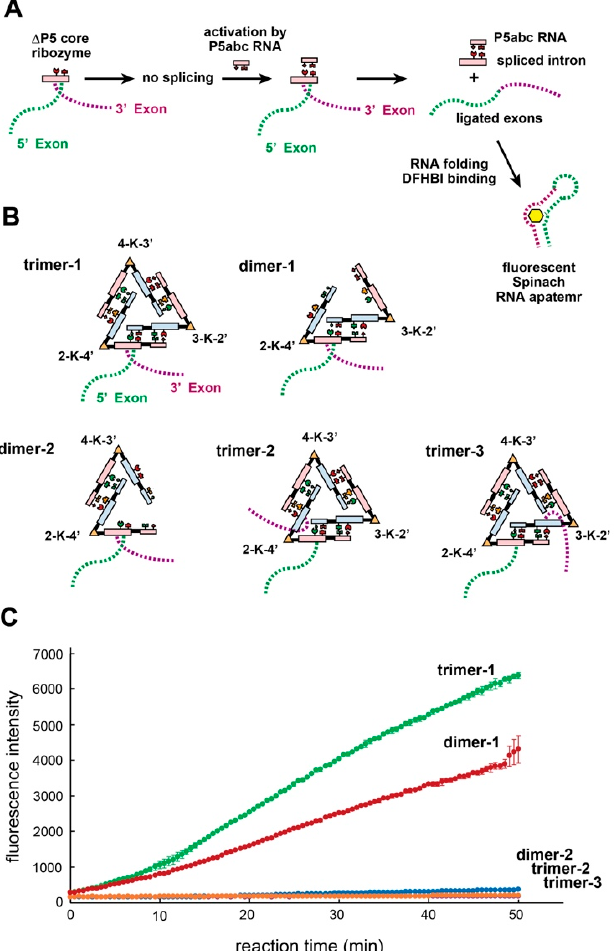
Figure 7. Trans -splicing reaction by the ribozyme unit 2 formed in the closed kUrd heterotrimer. ( A ) Parent cis -splicing reaction of the bimolecular group I ribozyme. 5 ′ and 3 ′ exons were both provided by the unimolecular ∆ P5 ribozyme RNA, the activity of which is repressed in the absence of the P5abc RNA. Splicing reaction produced Spinach RNA as the ligated exons. Spinach RNA captured DFHBI and induced its fluorescence. ( B ) Closed kUrd trimers and their partial dimers used for analysis of the trans -splicing reaction. ( C ) Time-dependent increases in fluorescence of Spinach RNA–DFHBI complex. Splicing reactions were carried out at 37 °C.